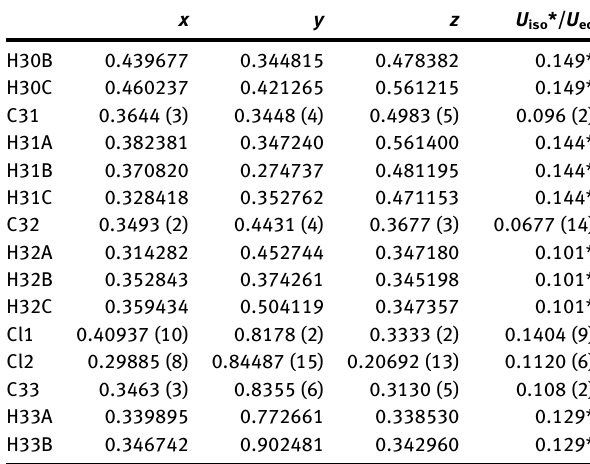
Table  : Fractional atomic coordinates and isotropic or equivalent isotropic displacement parameters (Å 